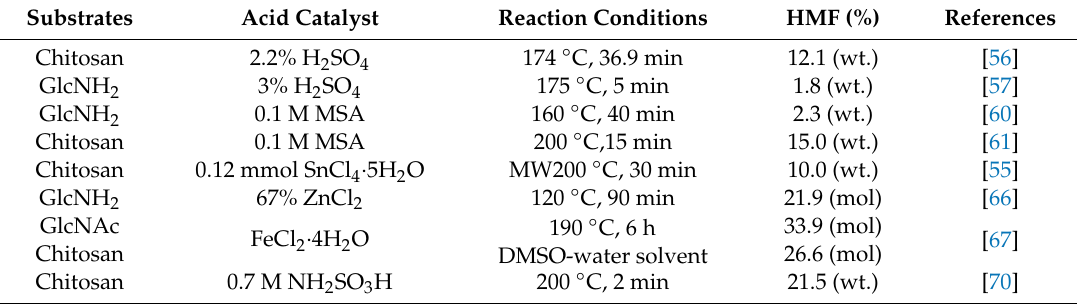
Table 2. HMF production from biomass by acid